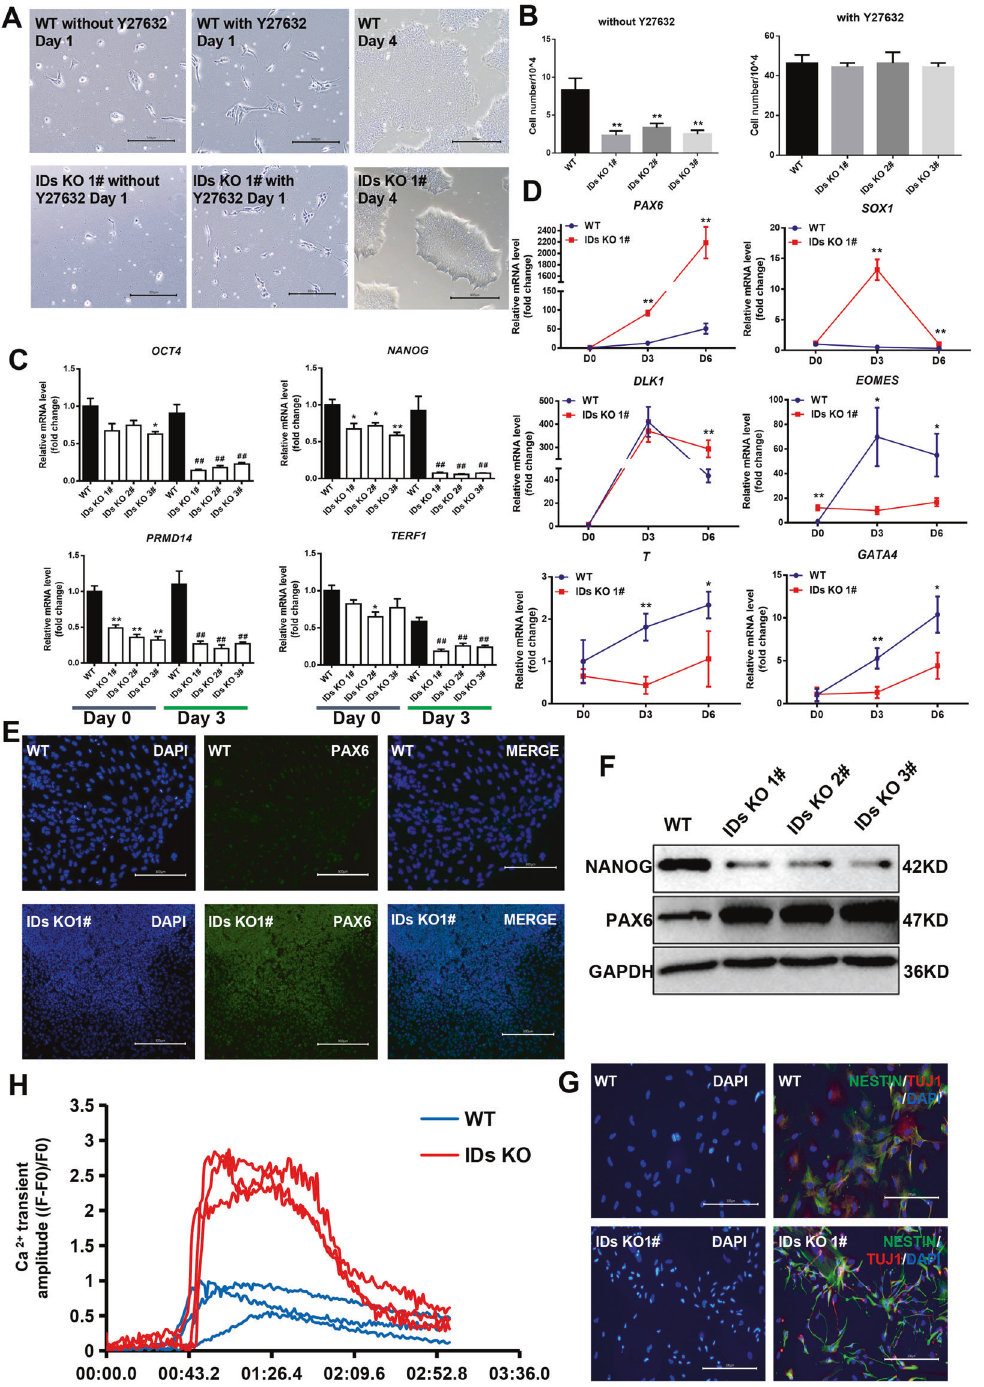
Fig. 1 ID1 and ID3 double knockout impairs the survival and promotes ectoderm speci fi cation of primed hESCs. A Clone morphology of the WT and double knockout lines after culturing for 4 days and the clone outgrowth of the WT and double KO lines after supplementation with or without Y27632, bar = 300 μ m. B Number of the WT and IDs KO cells after four days of culture with or without Y27632 ( n = 3), ** p < 0.01 compared with WT, t- test. C Pluripotent markers expression level of the WT and double knockout lines after spontaneous differentiation at day 0 and day 3 ( n = 3), * p < 0.05; ** p < 0.01 compared with day 0 WT; # p < 0.05; ## p < 0.01 compared with day 3 WT, one-way ANOVA followed by t -test. D mRNA levels of mesoderm, endoderm, and neuroectoderm markers in the WT and double knockout lines were measured via qPCR at the indicated time points, as the cells spontaneously differentiated into embryoid bodies (EBs); the results were normalized to measurements for the WT cells at the beginning of the differentiation period ( n = 3). * p < 0.05; ** p < 0.01 compared with the WT; one-way ANOVA followed by t -test. E Immuno fl uorescence analysis of PAX6 expression levels in the WT and KO lines after spontaneous differentiation, bar = 300 μ m. F The protien levels of NANOG and PAX6 were detected by immunoblotting after three days spontaneous differentiation. G Immuno fl uorescence analysis of NESTIN and TUJ1 ( β 3-TUBLIN) expression levels in the WT and double KO lines after spontaneous differentiation, bar = 200 μ m. H Detection of calcium in fl ux in differentiated neurons after stimulation with glutamic acid.